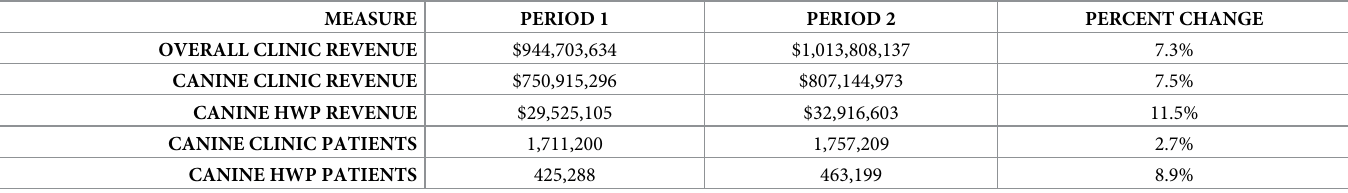
Table 7. All practice revenue comparison Period 1 vs Period 2. PH 6 only users.